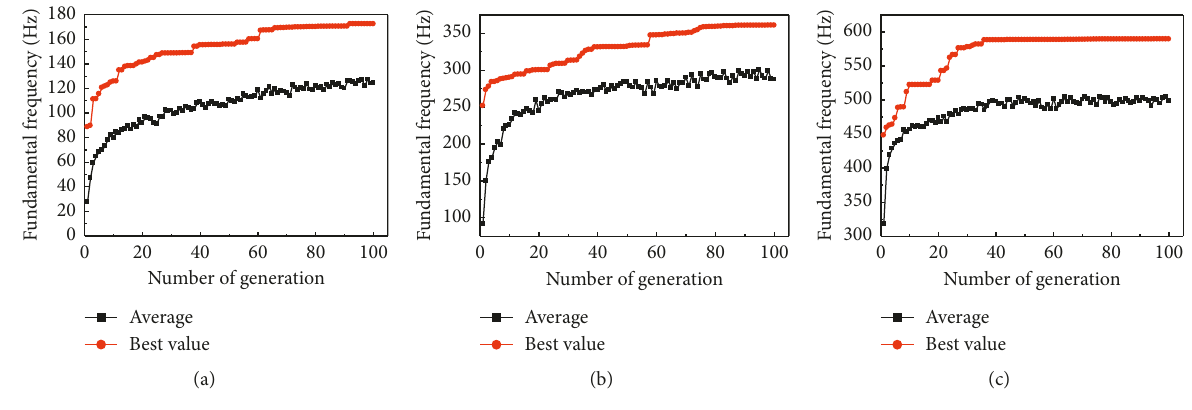
Figure 6: Evolution processes of MIGA in Example 1. (a) Shell 1. (b) Shell 2. (c) Shell 3. Table 3: Comparison of fundamental frequency of initial and finial generations in Example 1